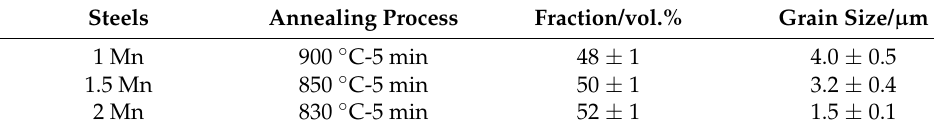
Figure 1. Schematic representation of the δ -TRIP steels heat treatment.